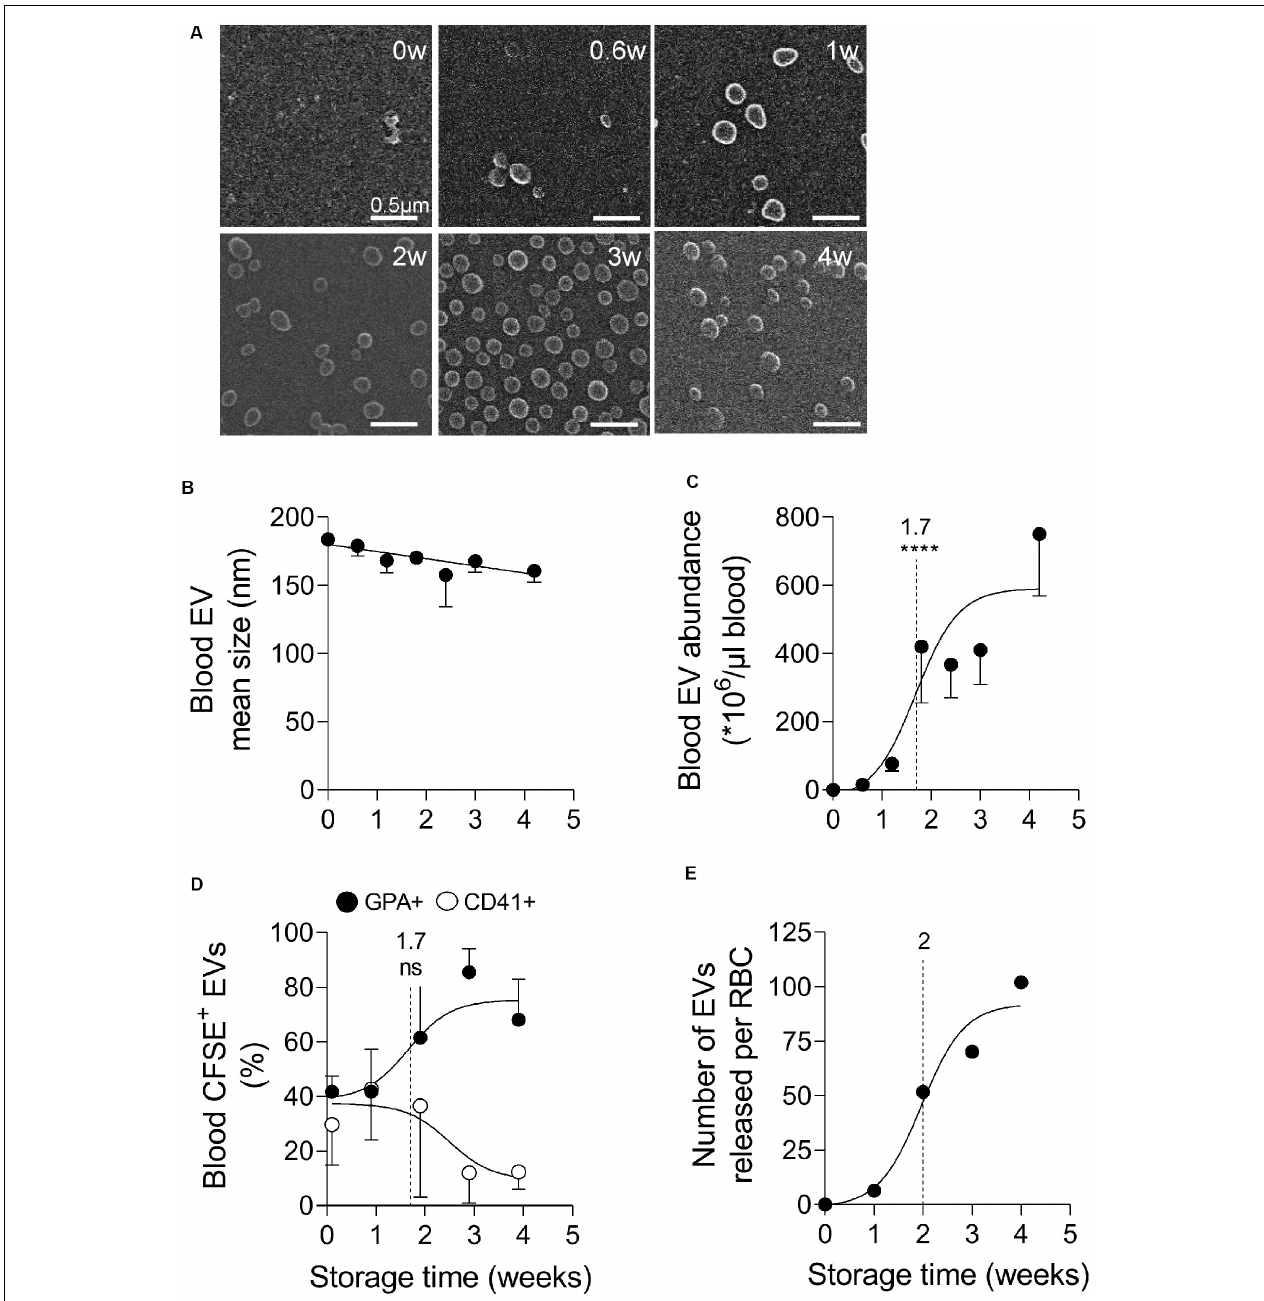
FIGURE 2 | Blood extracellular vesicles increase in abundance upon storage and originate from both platelets and RBCs in the first 2 weeks of storage, then mainly from RBCs. Extracellular vesicles (EVs), isolated by ultracentrifugation from plasmas obtained from K + /EDTA tubes stored at 4 ◦ C for the indicated times, were analyzed for morphology (A) , size (B) , abundance (C) , and cellular origin (D,E) . The time needed to reach 50% effect and the corresponding statistical analysis (Mann–Whitney U test) are indicated above the vertical dotted line. (A) EV morphology evidenced by electron microscopy. Isolated EVs were immobilized on PLL-coated coverslips, fixed with glutaraldehyde, post-fixed with osmium tetroxide, gold-labeled and observed by electron microscopy. Representative images from 1 experiment. (B,C) EV size and concentration determined by nanoparticle tracking analysis using the ZetaView. In (B) , EV size expressed in nm. In (C) , number of EVs/ µ l of blood determined as follows. The number of EVs/ µ l of liquid in which EVs were suspended was determined by the Zetaview and then normalized by the factor between the volume of plasma used for EV isolation and the volume of plasma contained in 1 µ l of blood (i.e., 0.6 µ l). Data are means ± SEM of 5 independent experiments. (D) Proportion of blood EVs produced by RBCs and platelets determined by flow cytometry. Isolated EVs were labeled with fluorescent carboxyfluorescein succinimidyl ester (CFSE) and anti-glycophrorin A (anti-GPA-AlexaFluor647; black circles) and -CD41 (anti-CD41-PE; white circles) antibodies to respectively label EVs originating from RBCs and platelets and then analyzed by flow cytometry. Results are expressed as % of GPA (RBCs) or CD41 (platelets) positive CFSE-labeled EVs. Mean ± SEM of 4 independent experiments. (E) Estimation of the abundance of EVs released per RBC based on the number of EVs per µ l of blood (C) and the proportion of EVs produced by RBCs (D) . ns, not significant; **** p < 0.0001.